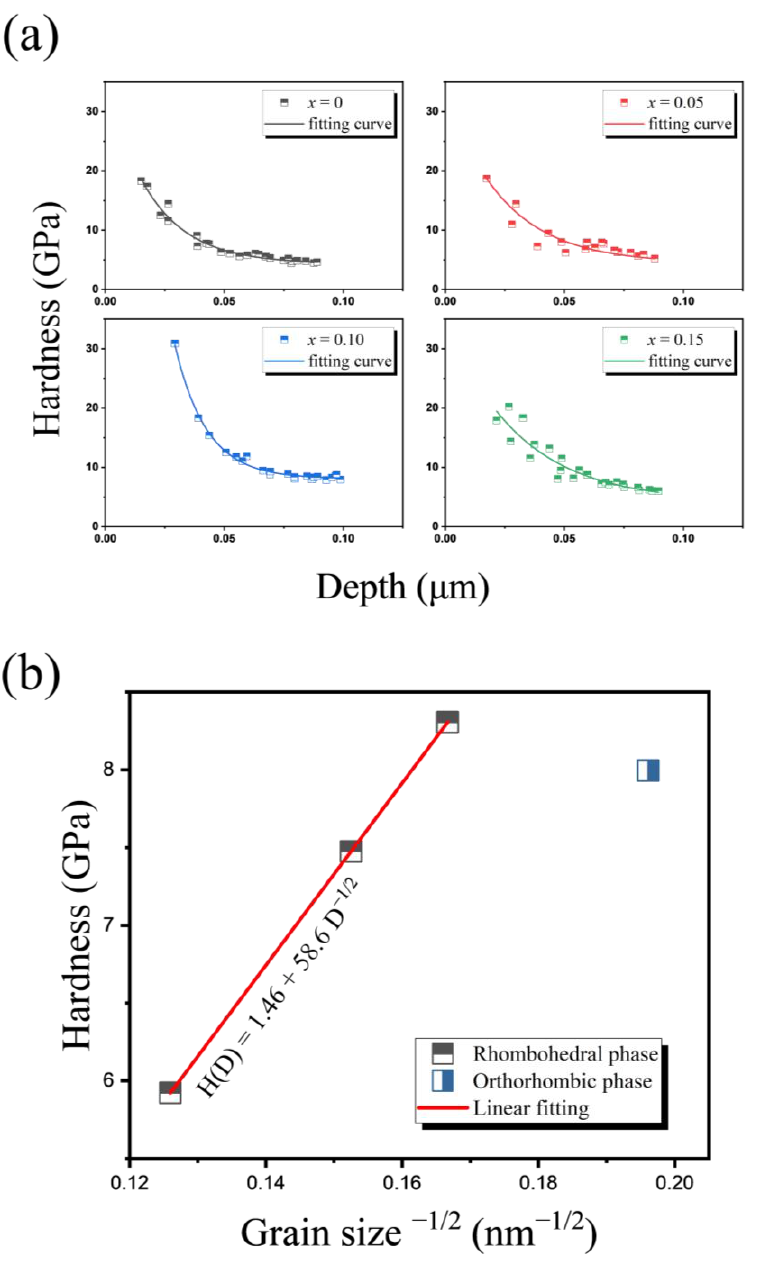
Figure 10. ( a ) Hardness versus depth curves and ( b ) Hardness versus grain size − 1/2 of Bi 1− x Gd x FeO 3 films.